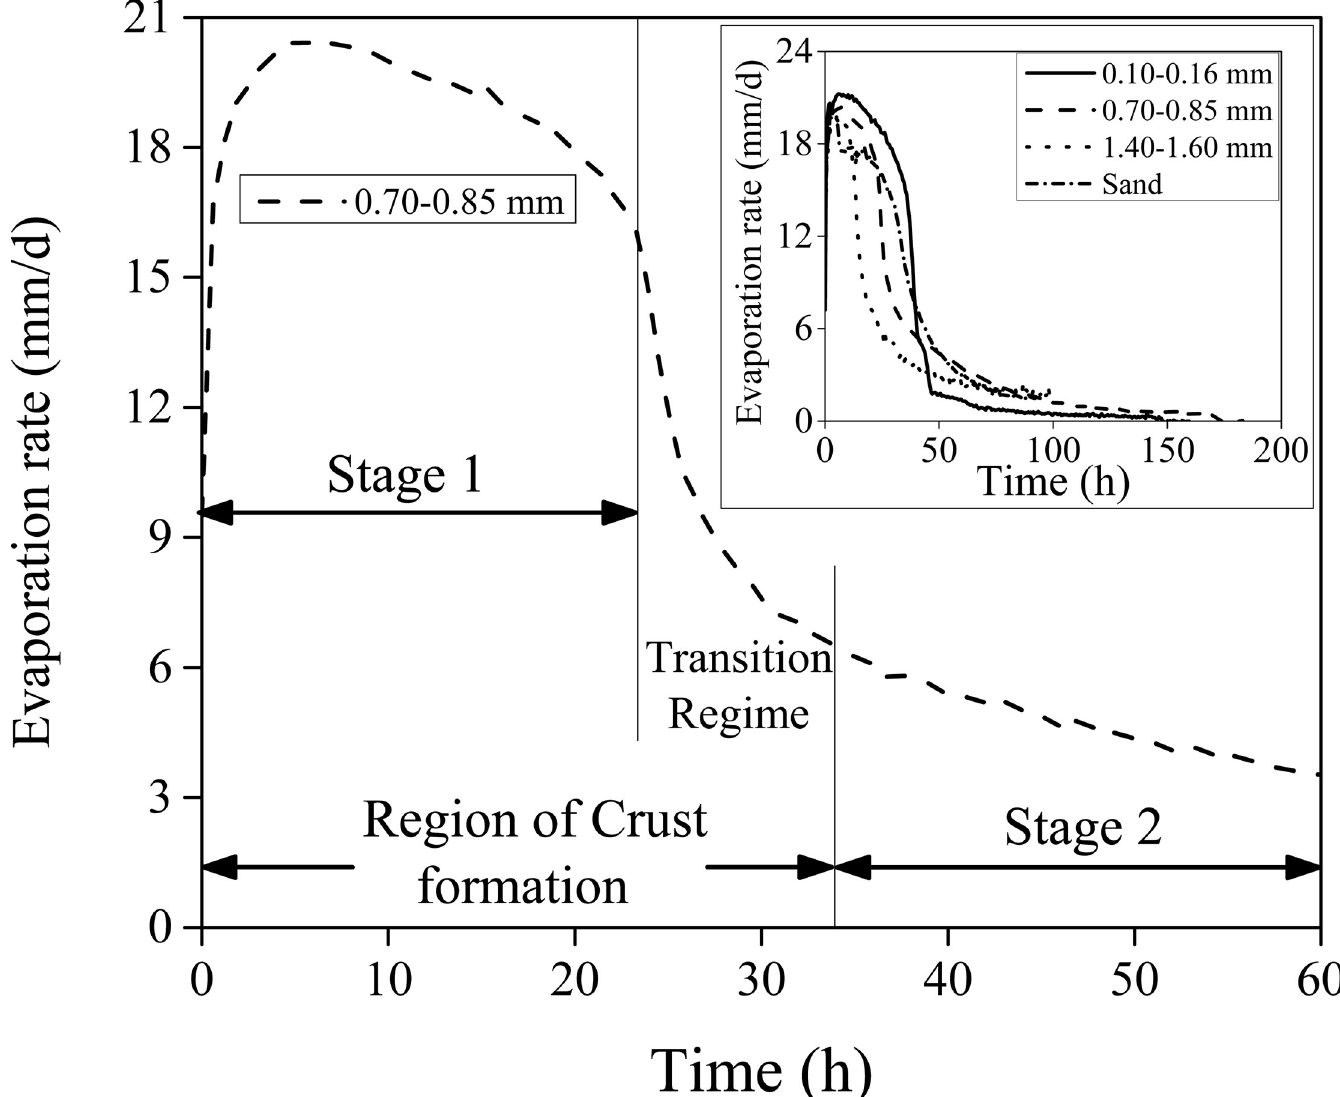
Fig 1. Variation of the evaporation rate versus time for the (hydrophilic) glass beads with 0.78 mm diameter. Curves for the other cases are seen in the inset. Heat flux received by the top surface in all the cases was ~1000 W/m 2 . ‘Sand’ was slightly more porous (~43% porosity) compared to the other cases with the (hydrophilic) glass beads (35–37%